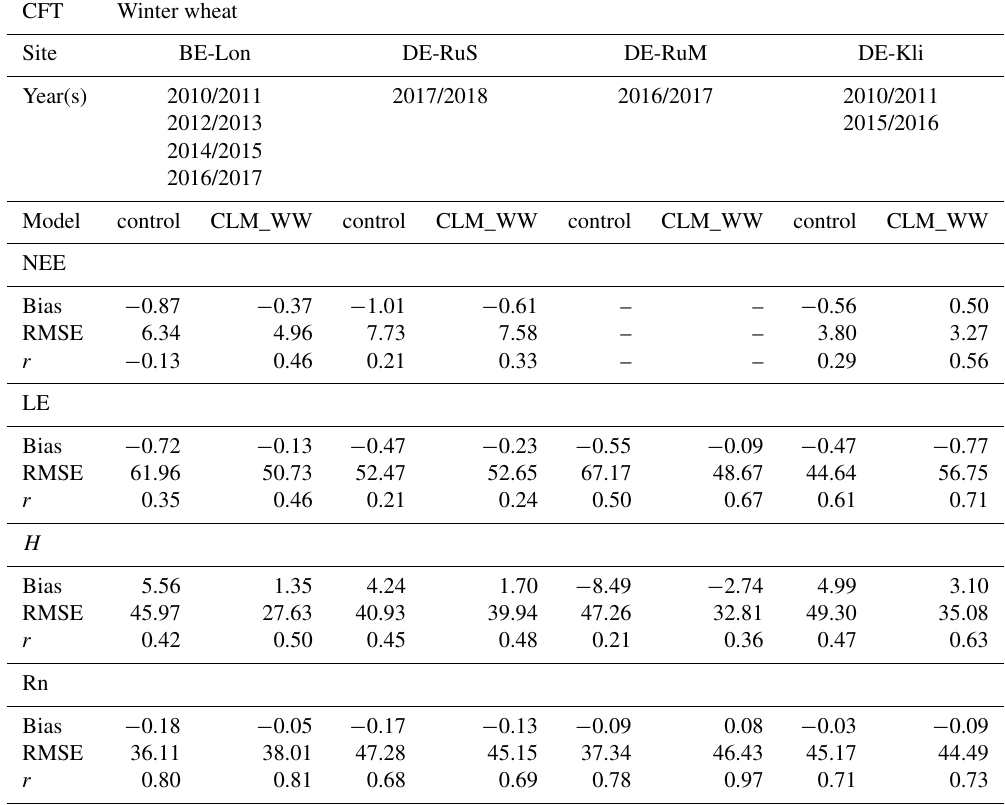
Table 4. Bias, root-mean-square error (RMSE), and Pearson correlation coefficient ( r ) for the control run and CLM_WW-simulated